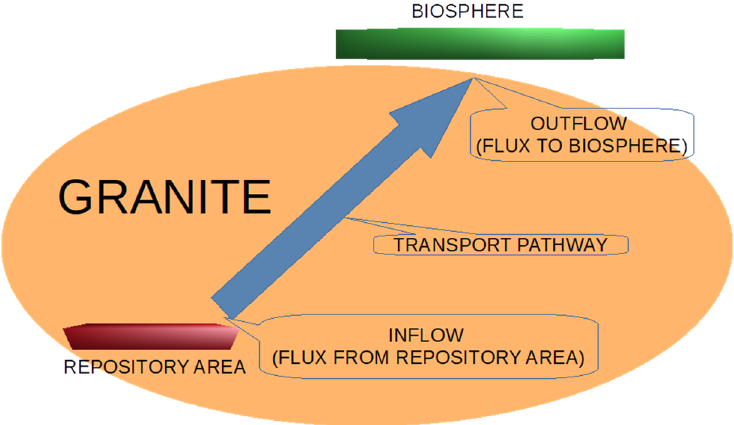
Figure 1. Scheme of a conceptual model of the deep geological repository for radioactive waste, highlighting the granite massif (i.e., the “geosphere” compartment) as the barrier of interest and the meaning of the LPM representation.